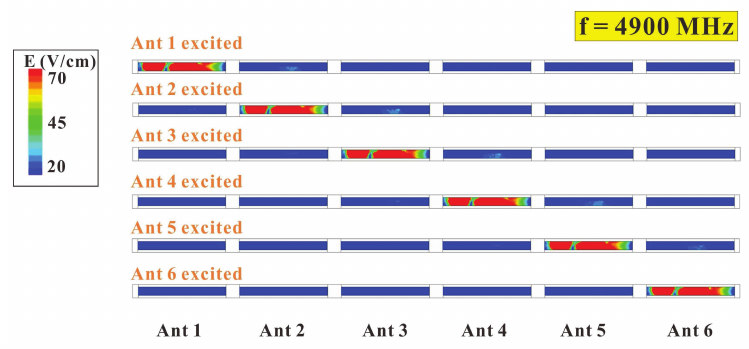
Figure 19. Simulated electronic field distribution of the six-antenna system at 4900